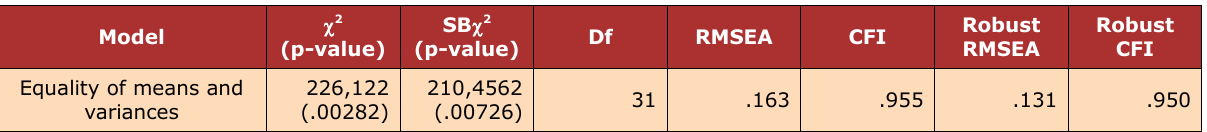
Table 3. Goodness of fit indexes for invariance of means and variances together